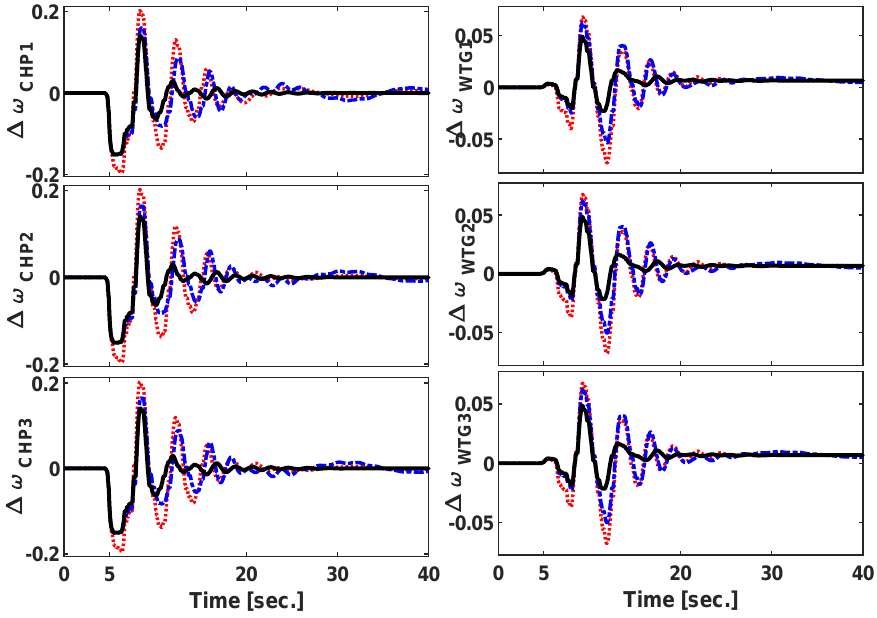
Figure 16. The oscillations of the angular velocity of generation units in scenario 1; black(solid): RL-PID, blue(dashed-dotted): F-PID, red(dotted):